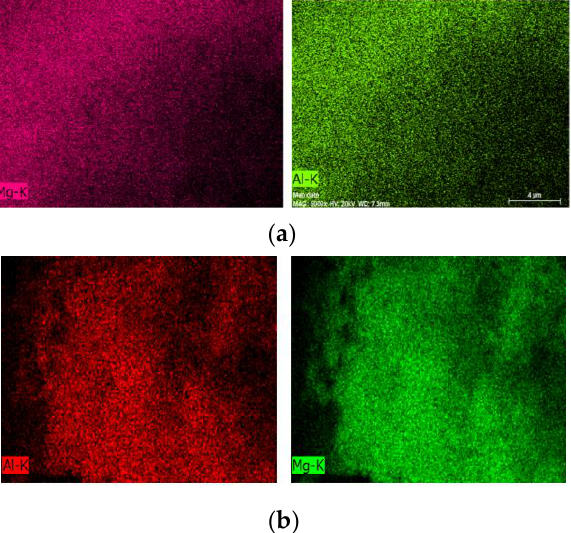
Figure 4. EDS (energy dispersive spectroscopy) LDH images of ( a ) as-synthesized Al,Mg-LDH and ( b ) calcined samples under O 2 flow and rehydrated with H 2 O vapor.